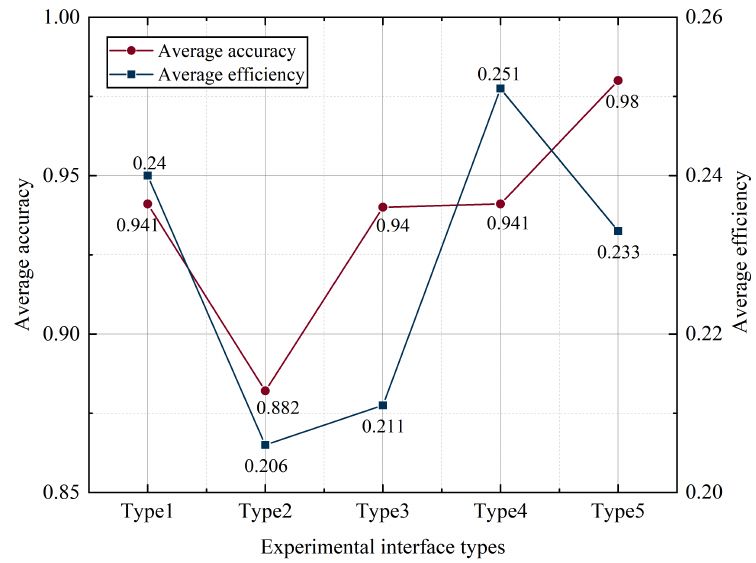
Figure 8. Decision quality of buttons of different sizes.